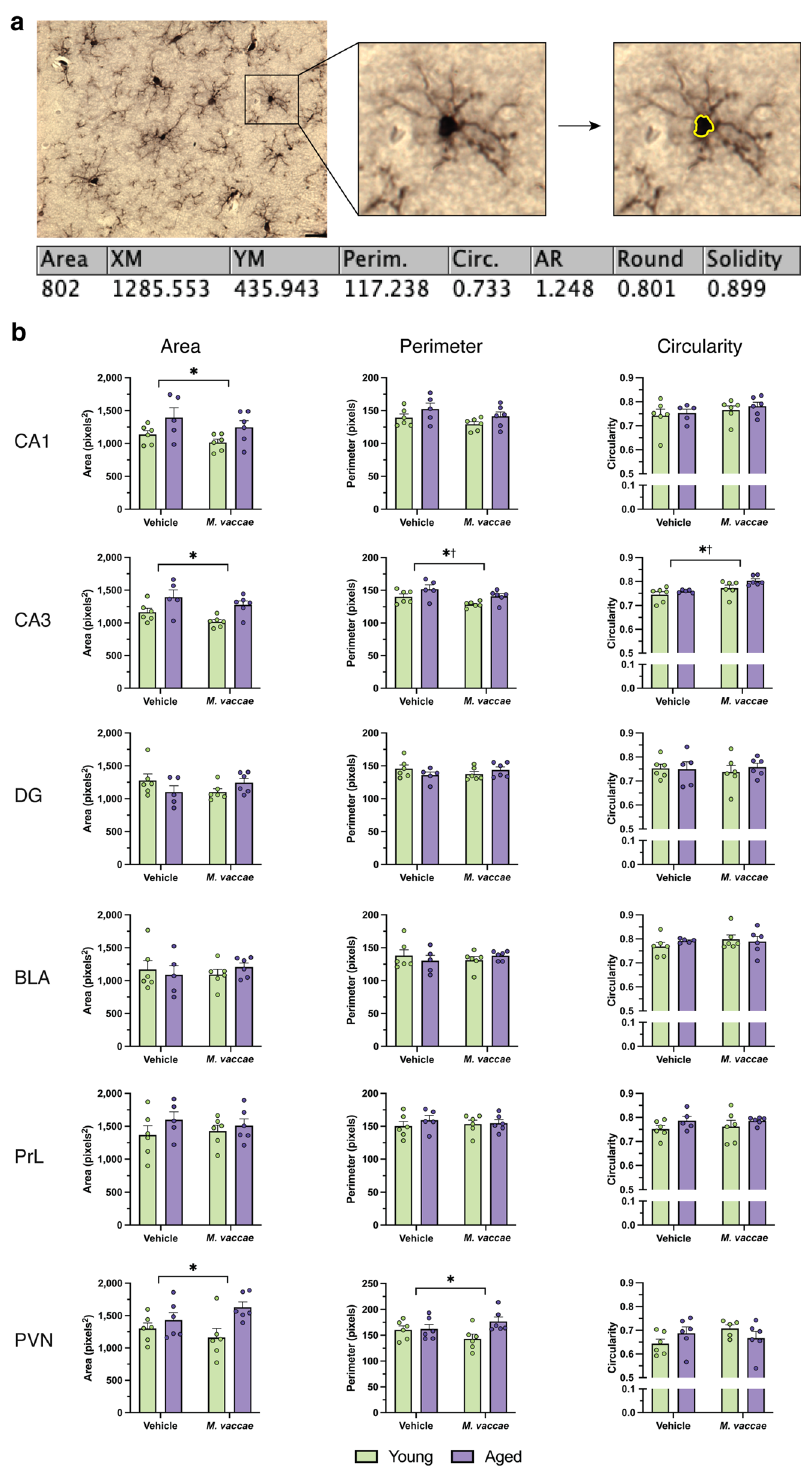
Figure 2. Microglia somas from the CA3 hippocampal subfield are responsive to the effects of both aging and M. vaccae immunization. ( a ) Methodology for assessing microglia soma morphology. Somas were traced using a graphic design tablet and analyzed using FIJI to automatically generate its area, perimeter, and circularity. ( b ) Values for the area, perimeter, and circularity of the microglial soma in the basolateral amygdala, CA1, CA3, dentate gyrus, paraventricular nucleus, and prelimbic cortex. The area was calculated in pixels squared based on the traced soma, and the perimeter was the number of pixels outlining that same soma. Circularity was 4 π A determined to be P 2 , where A is area and P is perimeter. A value of 1.0 represents a perfect circle, whereas an increasingly elongated shape has a circularity approaching 0.0. The data are graphed as mean ± SEM; n = 5–6 rats/group (12 microglia/rat); scale bar = 20 μm; * p < 0.05, main effect of age; † p < 0.05, main effect of M. vaccae